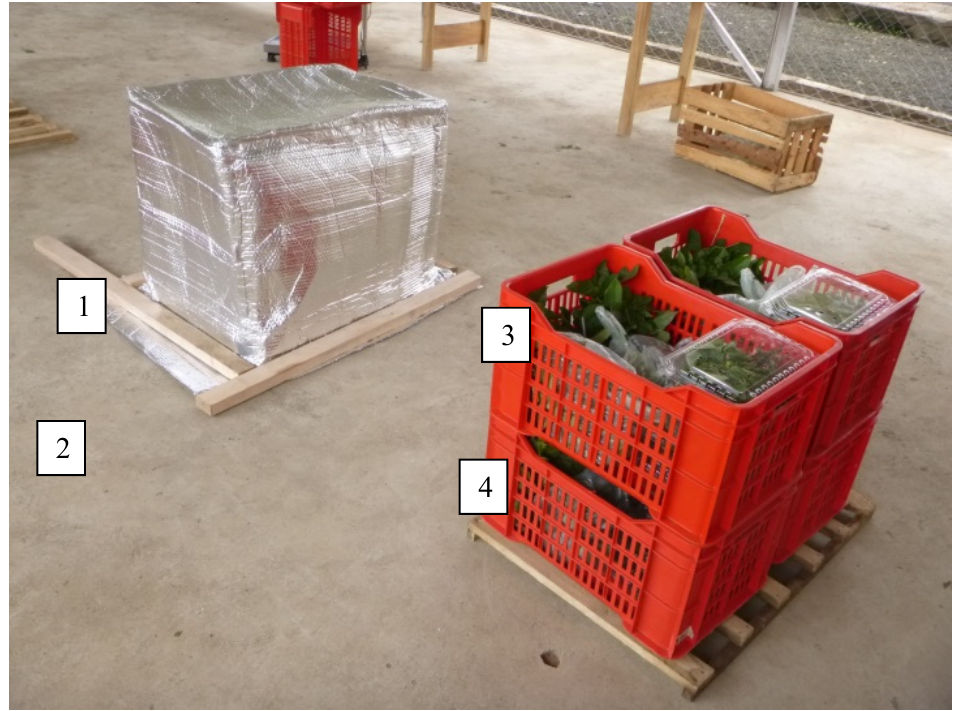
Figure 2. Stacking pattern for uncovered ( right ) and covered ( left ) returnable plastic crates placed on wooden pallets, with crates numbered one through